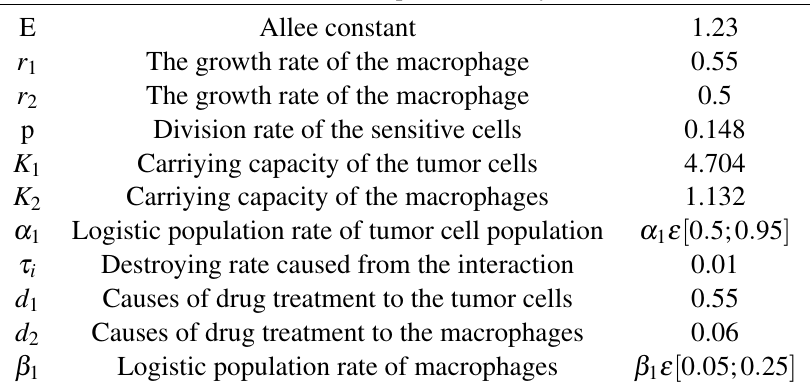
Table 1 Values of the parameter of system